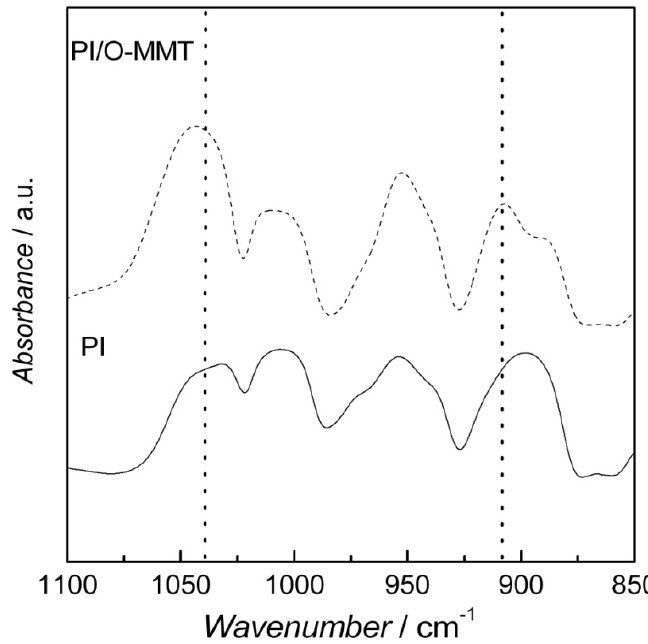
Figure 2. FTIR spectra of pure PI (full line) and PI/organically-modified montmorillonite (O-MMT) (dashed